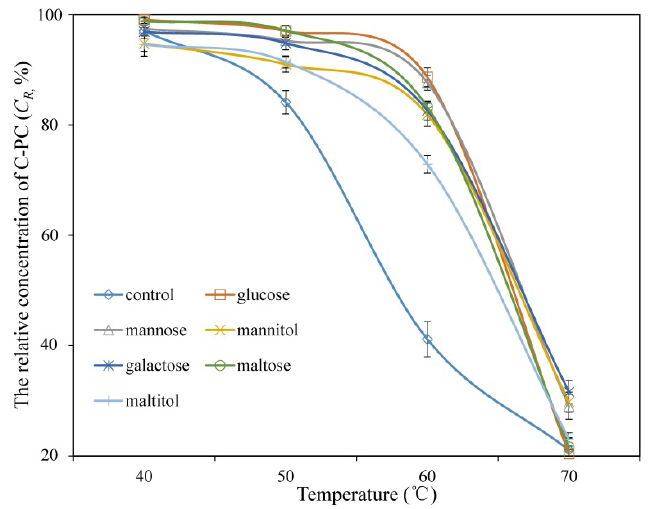
Figure 2. Relative concentration of C-PC treated with 30% additives after incubation for 1 h at different temperatures.